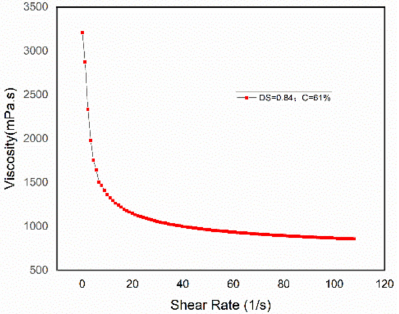
Figure 5. Relationship between apparent viscosity and shear rate.